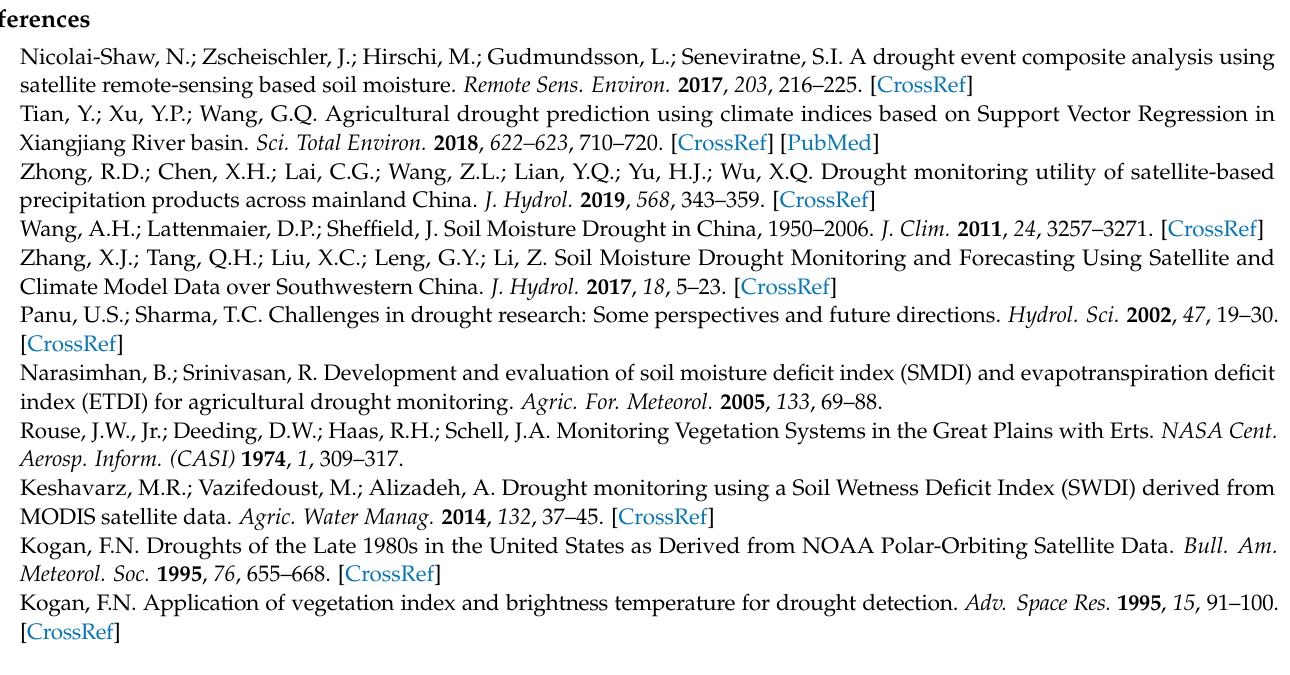
period (f); Figure S7: The distribution of drought event severity for 1981–1990 (a), 1991–2000